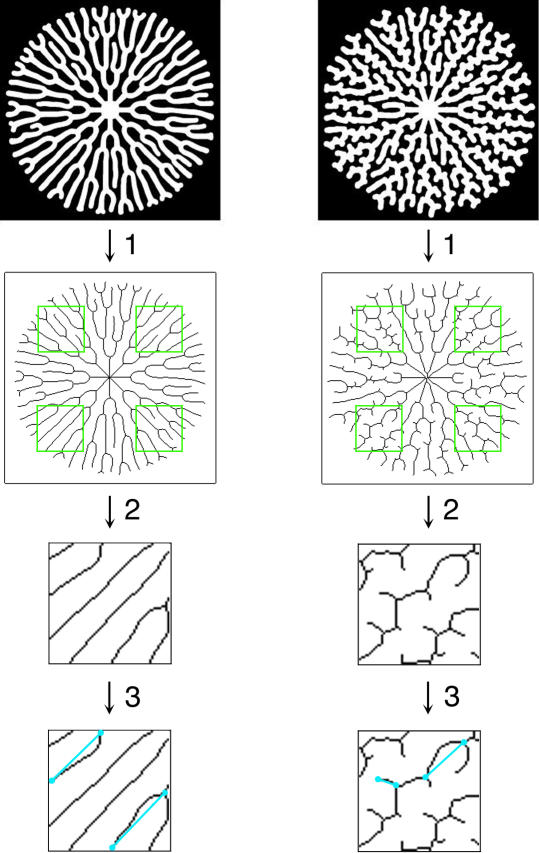
Procedures for Quantification of DOBStep 1: Skeletonize images with ImageJ. Step 2: Crop four pairs of squares. Step 3: Approximate each dendritic segment between the two branching points by a line segment connecting those points. Measure the angle of a branch segment with respect to the horizontal direction. Repeat measurement for all segments in each local area and calculate the coefficient of variation, DOB.